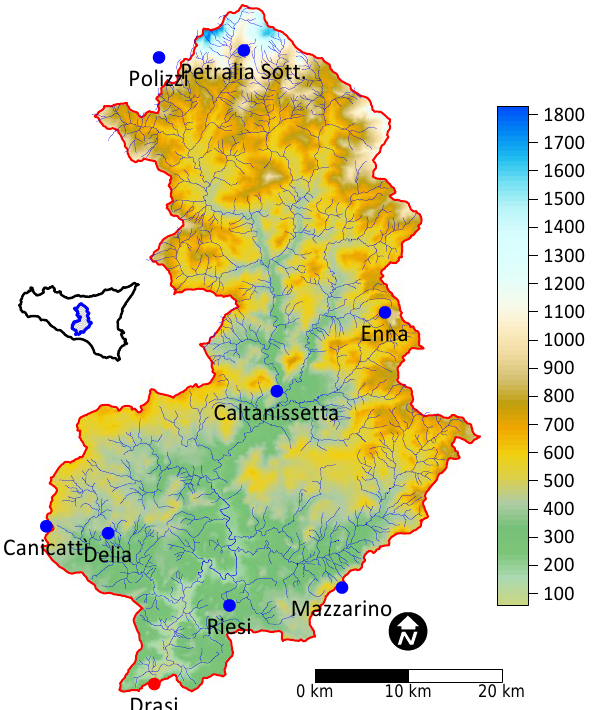
Figure 1. Imera catchment